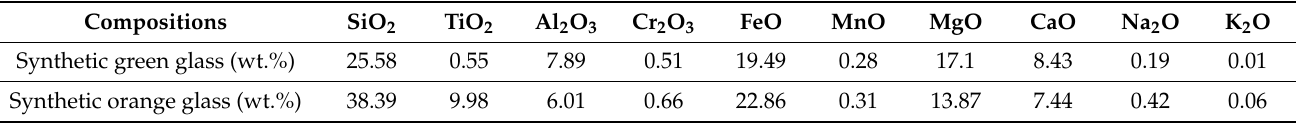
Table 1. The chemical compositions of the synthetic lunar green and orange glasses (from